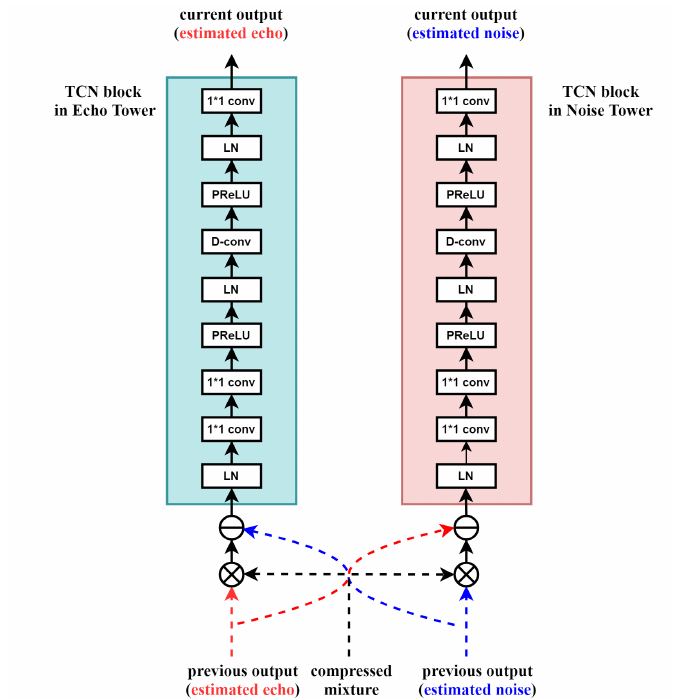
Figure 4. TCN block in the cross-tower